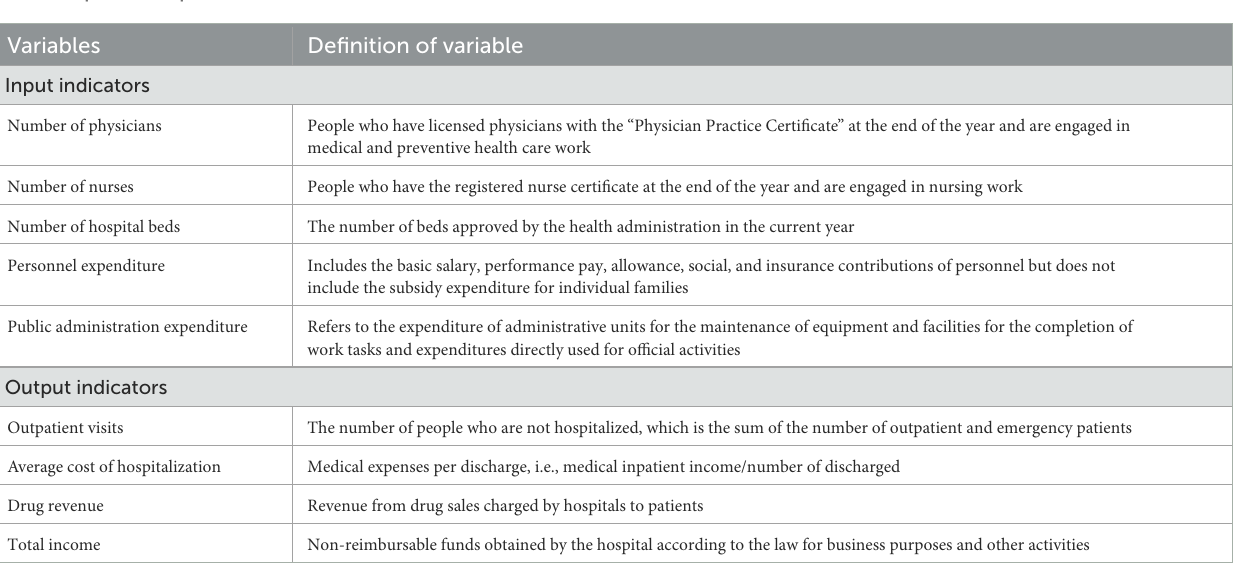
TABLE 3 Input and output indicators.